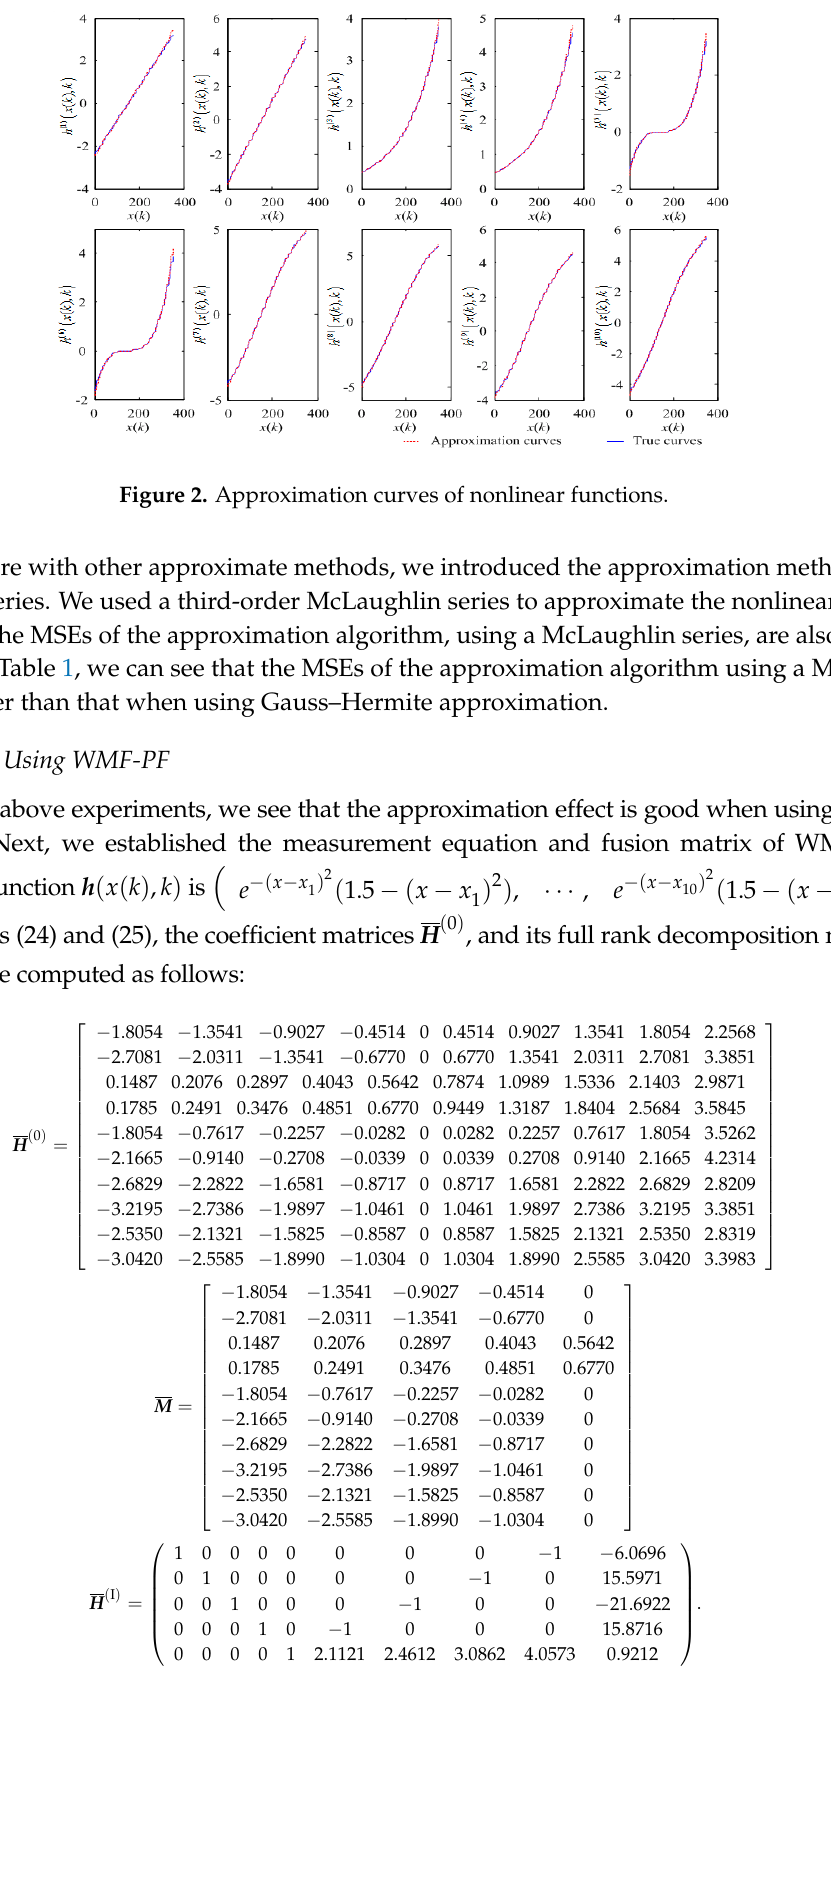
Table 1. Mean square errors.